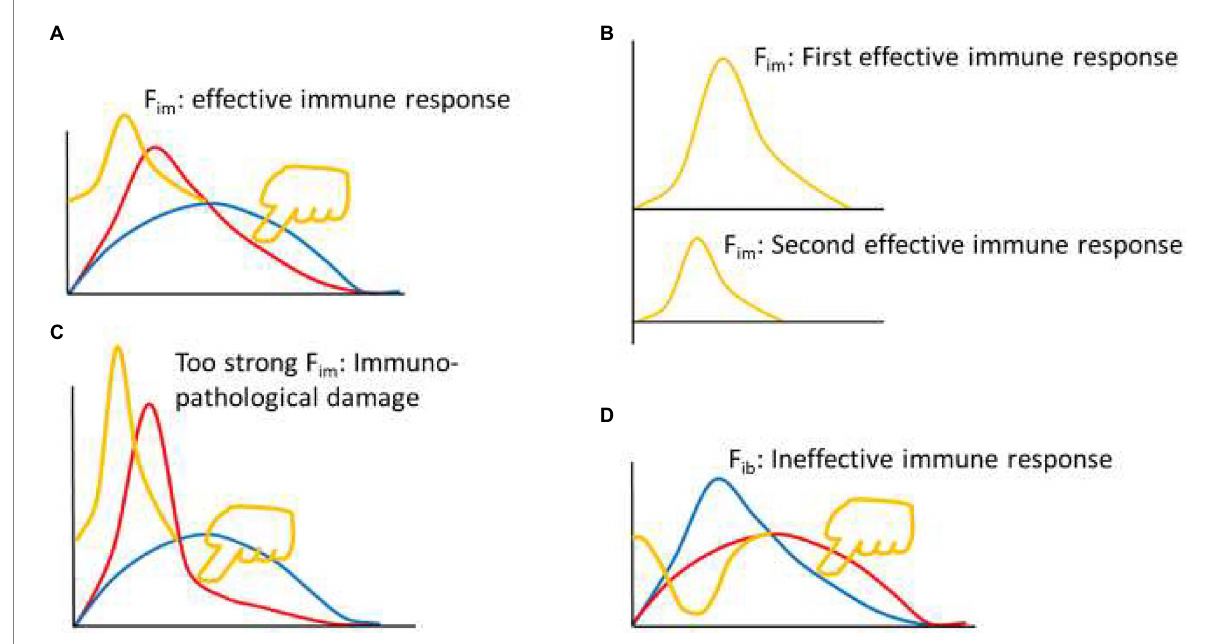
FIGURE 2 Thought experiment 2. (A) Pressing the red line from the upper right toward the lower left with appropriate force (finger in yellow color) to initiate appropriate F im dynamics (yellow curve), produced an effective immune response. (B) From the perspective of F im , the second effective immune response was a smaller version of the first effective immune response. (C) Excessive pressure (finger in yellow color) to the red line induced excessive F im , leading to immunopathological damage. (D) Pressing the blue line from the upper right toward the lower left (finger in yellow color) induced dynamic changes of immune braking force (F ib , yellow curve) and produced an ineffective immune